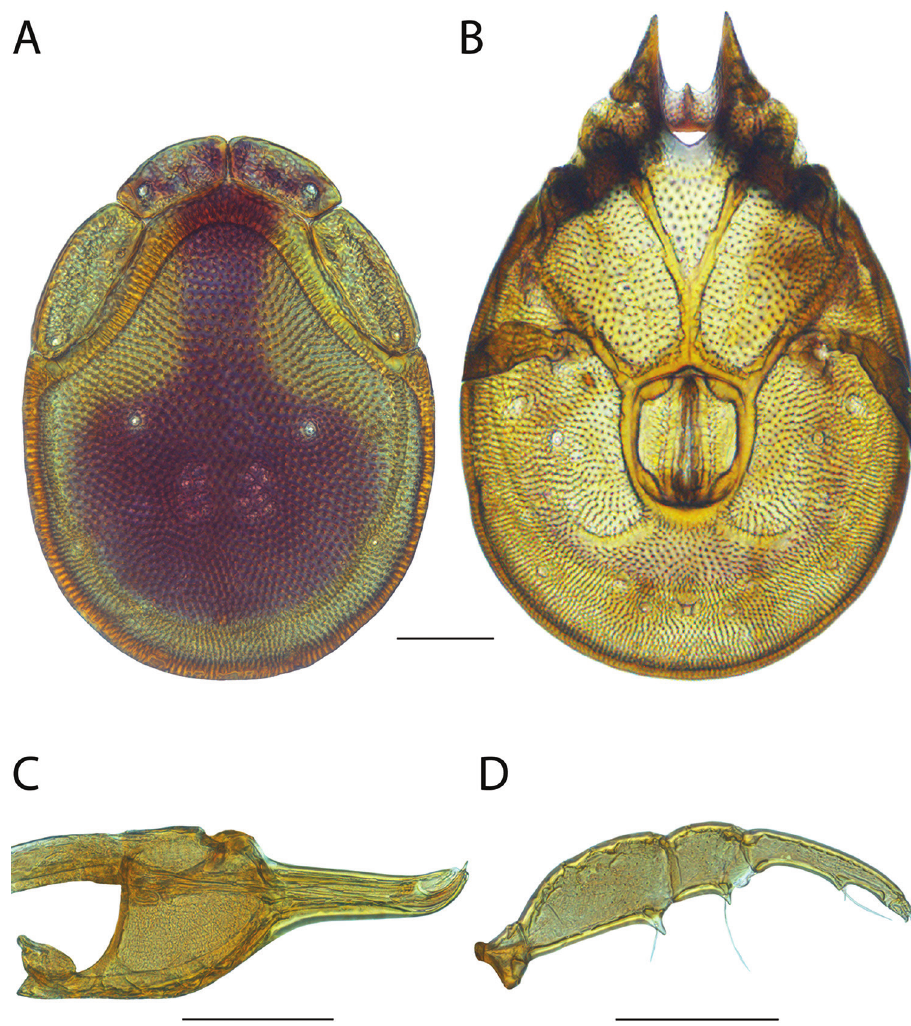
Figure 107. Torrenticola ivyae sp. n. male: A dorsal plates B venter (legs removed) C subcapitulum D pedipalp (setae not accurately depicted). Scale = 100